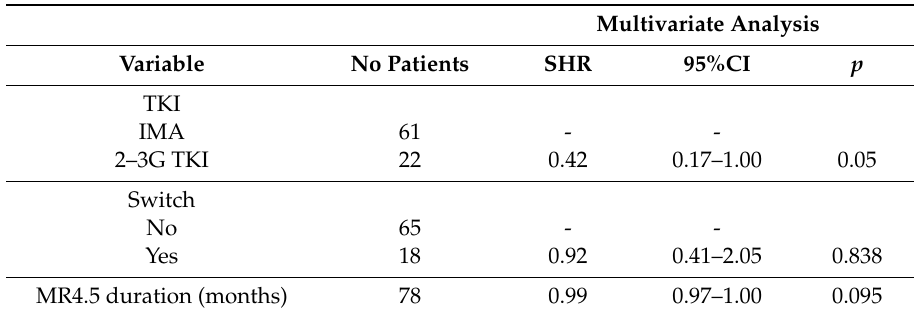
Table 5. Supplemental. Predictive factors of molecular recurrence after tyrosine kinase inhibitors discontinuation by multivariate Cox regression model